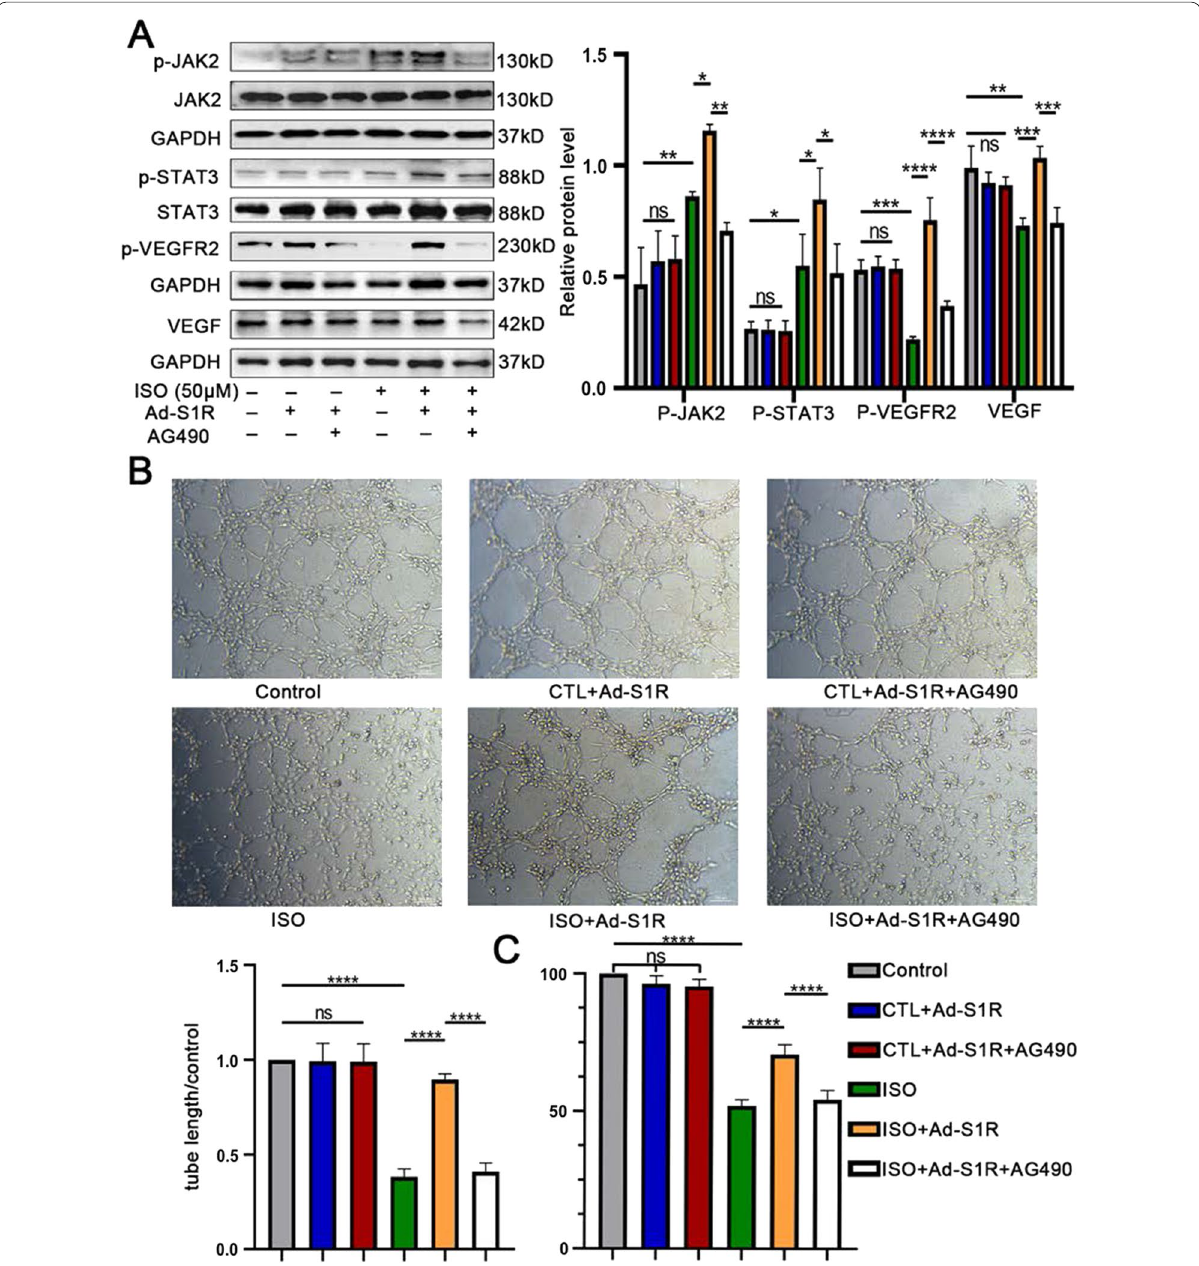
Fig. 6 Transfection of Ad-S1R promoted angiogenesis of HUVECs through JAK2/STAT3 signaling pathway. A Western blot results showed that AG490 inhibited JAK2/STAT3 signaling pathway activation. N 3 for quantified analysis; B In vitro incubation of JAK2/STAT3 inhibitor 50 μM AG490 = decreased tube formation; C AG490 counteracted the pro-proliferative effect of Ad-S1R transfection on HUVECs; *P < 0.05; **P < 0.01; ***P < 0.005; ****P <